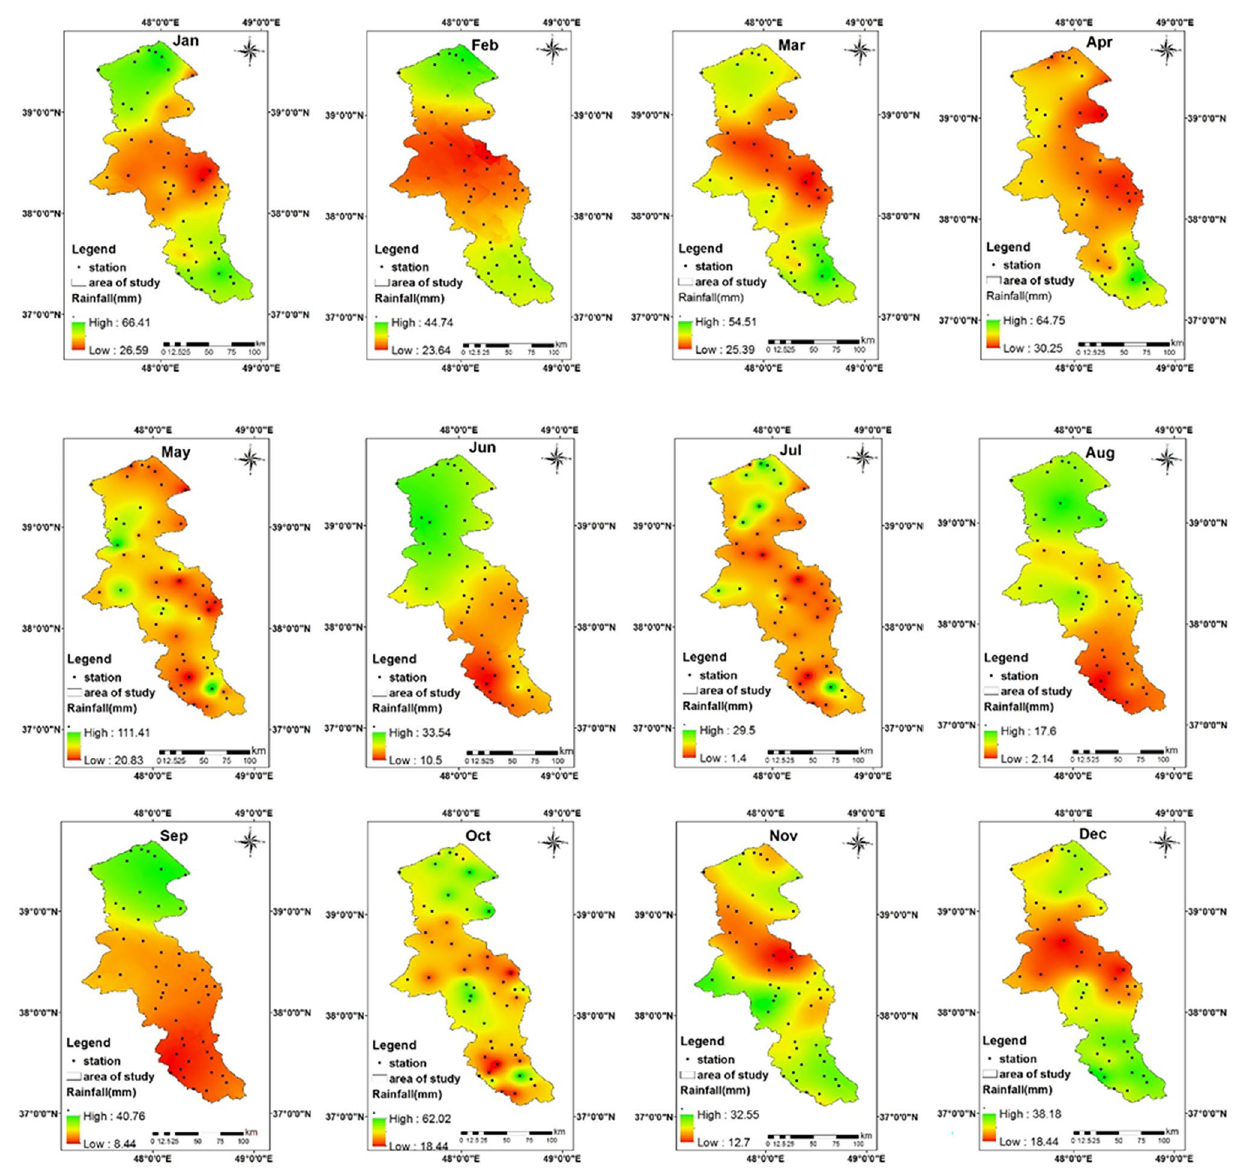
Fig. 2 Thematic rainfall maps of the time evolution month by month for